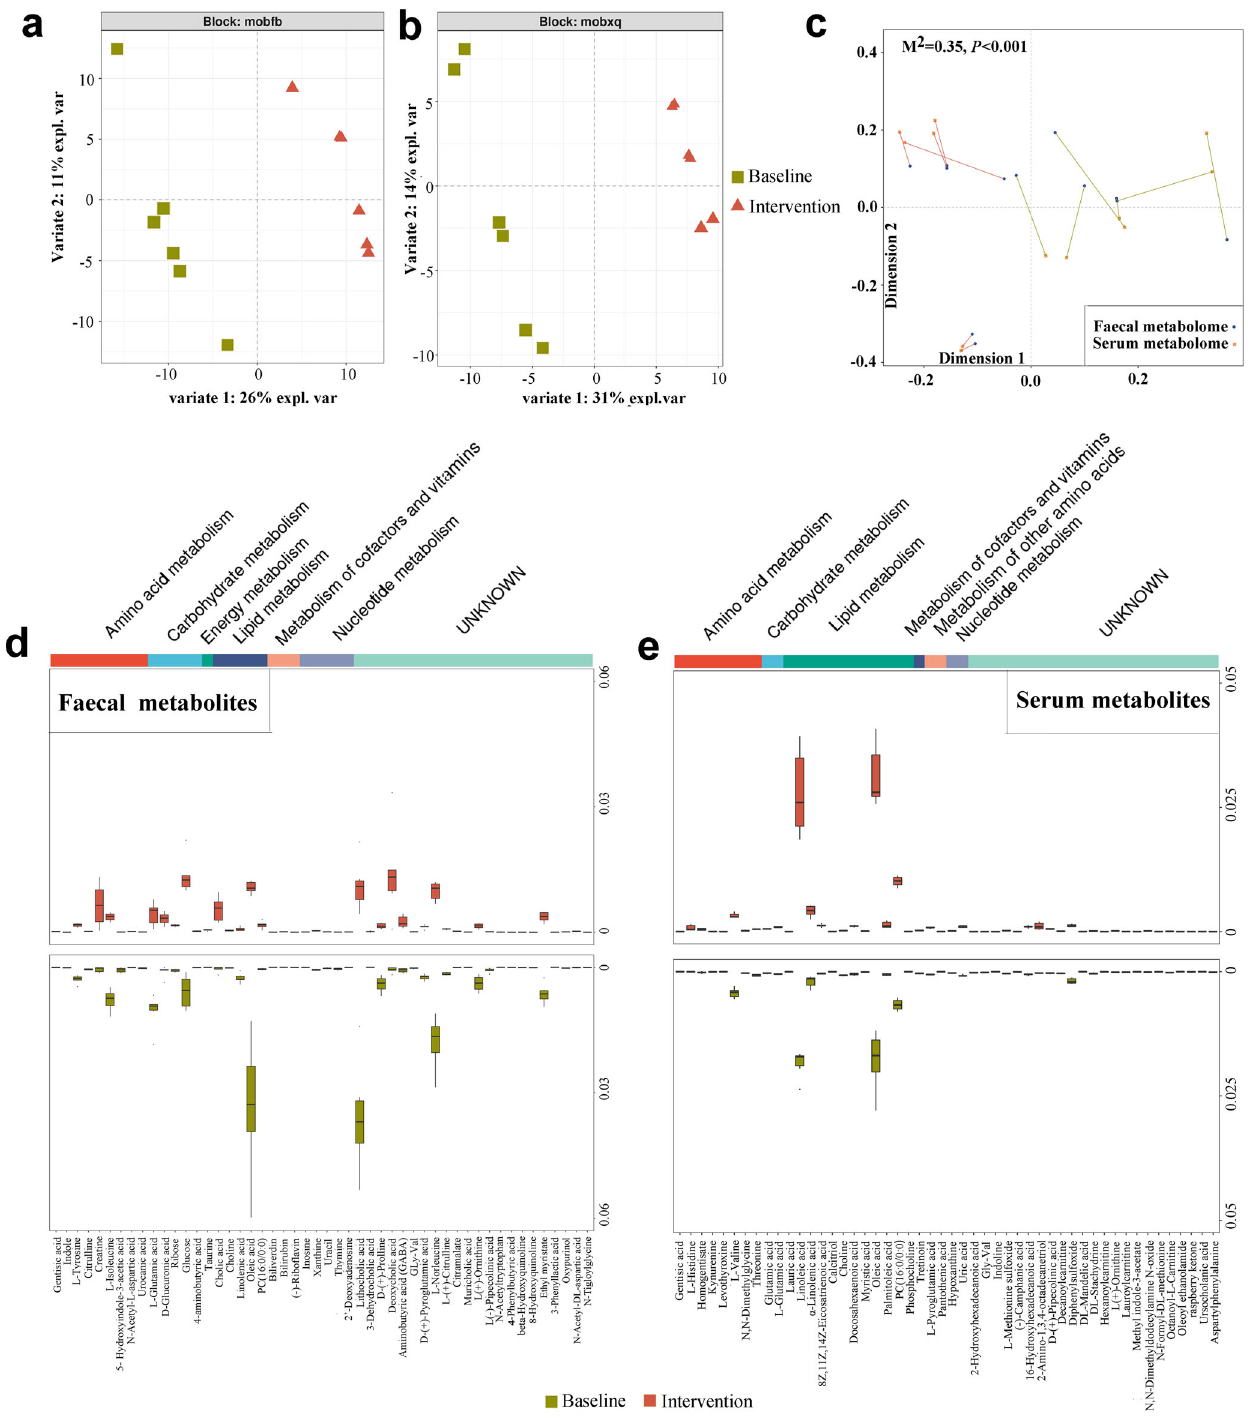
Fig. 4 Probiotic yogurt altered fecal and serum metabolomes after 12 weeks of intervention. DIABLO sample plots comparing the fecal and serum metabolites before and after yogurt intervention. a Separation of fecal metabolome between the baseline and intervention groups after 12 weeks of probiotic yogurt intervention, as shown using DIABLO. n = 6 in each group. b Separation of serum metabolome between the baseline and intervention groups after 12 weeks of probiotic yogurt intervention, as shown using DIABLO. n = 6 in each group. Each point in fi gures a and b represents an individual sample. c Procrustes analysis of fecal metabolome versus serum metabolome. Fecal and serum samples are shown as blue and orange dots, respectively; fecal and serum samples from the same individuals are connected by red (baseline) and cyan (intervention) lines. The top 50 differential metabolites ( d ) and differential serum metabolites ( e ) between groups before and after probiotic yogurt intervention. The differential abundance of fecal and serum metabolites between the two groups was evaluated using Student ’ s t